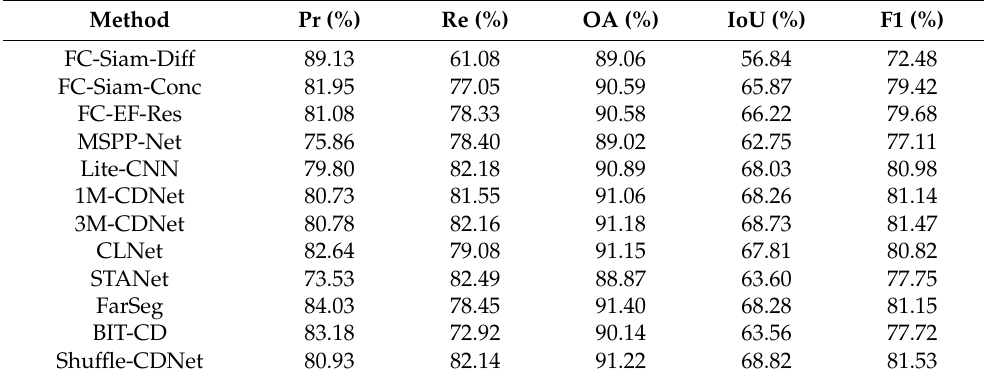
Table 4. Comparison results on the SYSU-CD dataset.